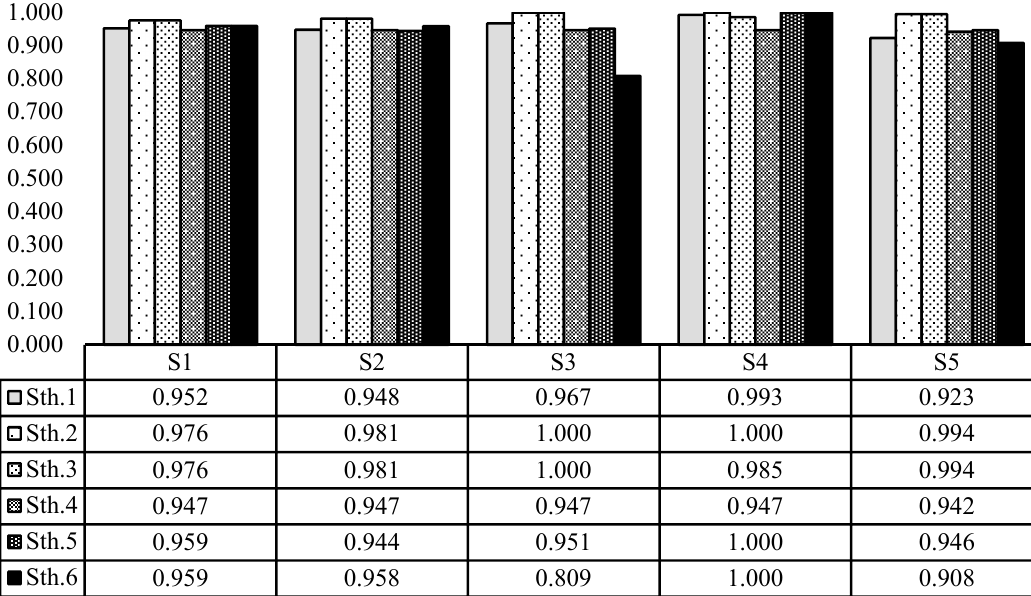
Figure 11. Scores of the water strategies in each stakeholder’s viewpoint (satisfying at least one criterion).